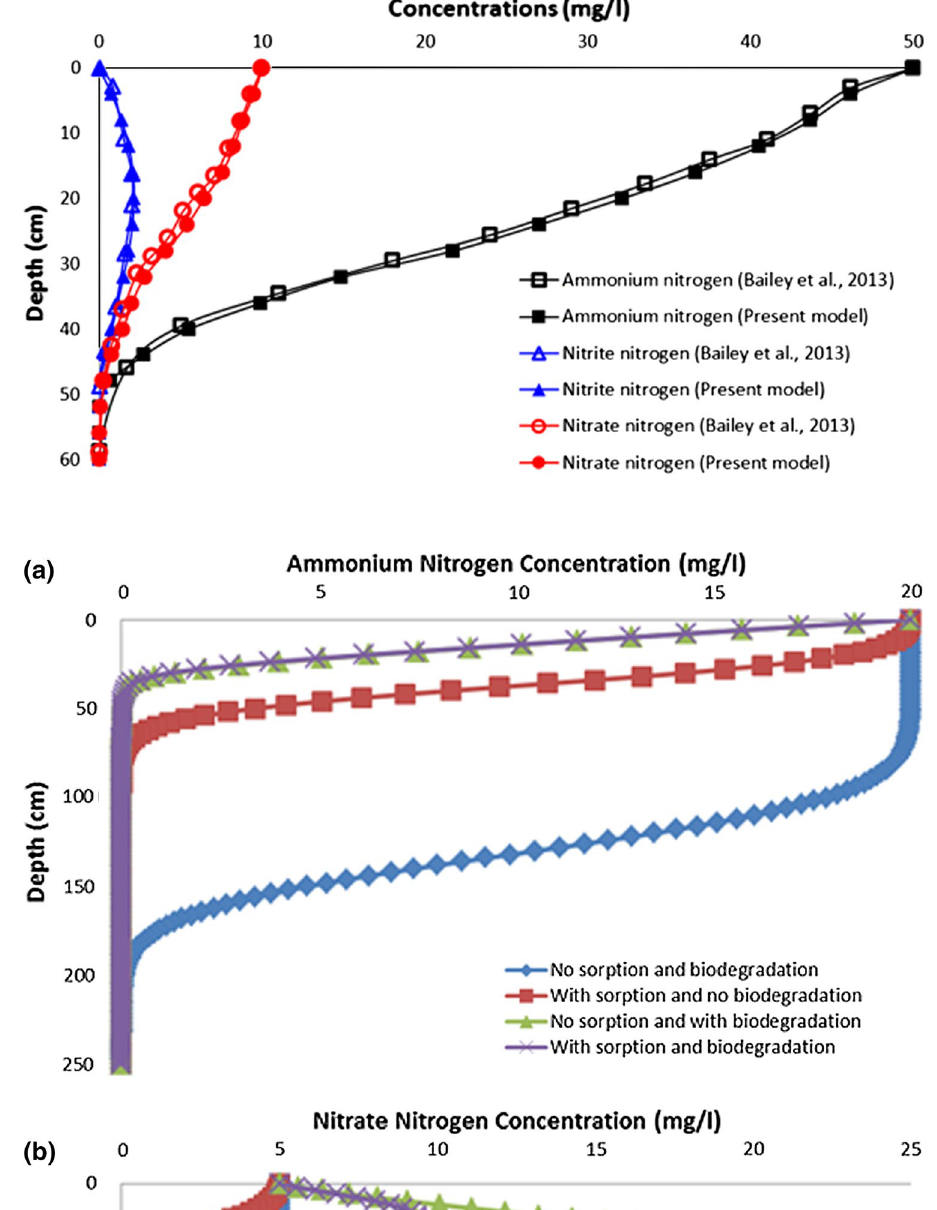
Fig. 2 Validation of nitrogen species transport model for ammonium, nitrite and nitrate nitrogen concentration in unsaturated porous media